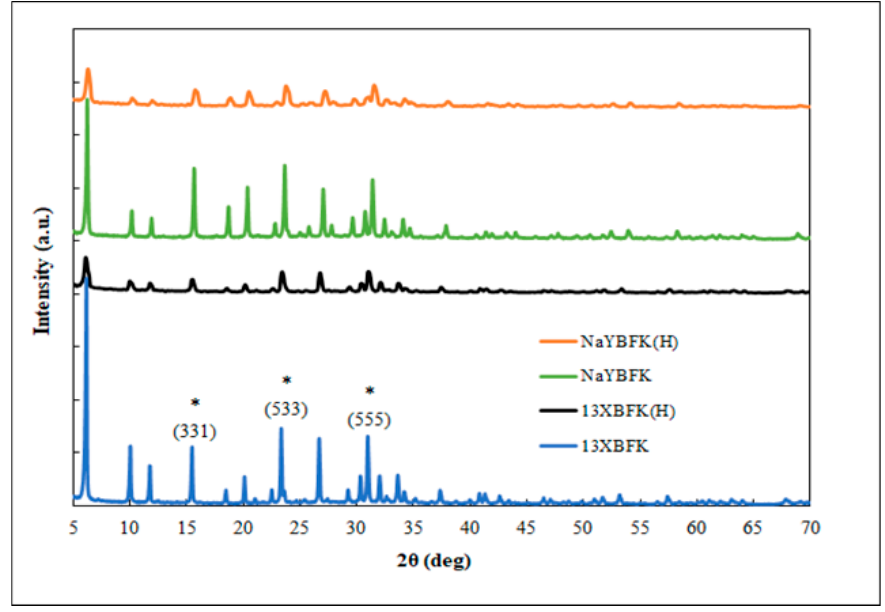
Figure 1. XRD pattern of NaYBFK, NaYBFK(H), 13XBFK and